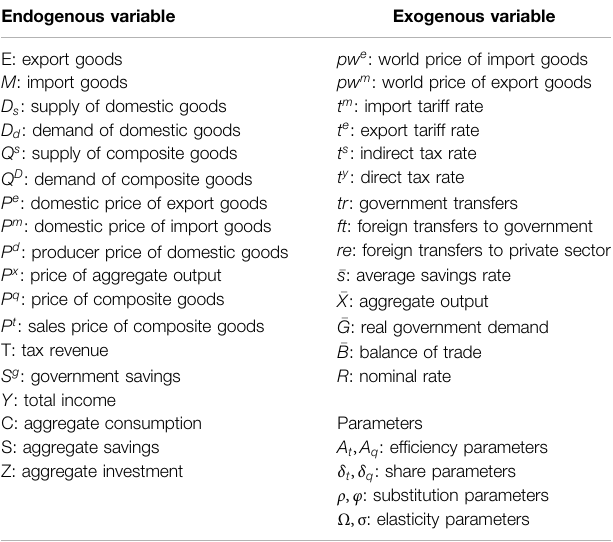
TABLE 1 | Variables and parameters in the “ 1-2-3 ”